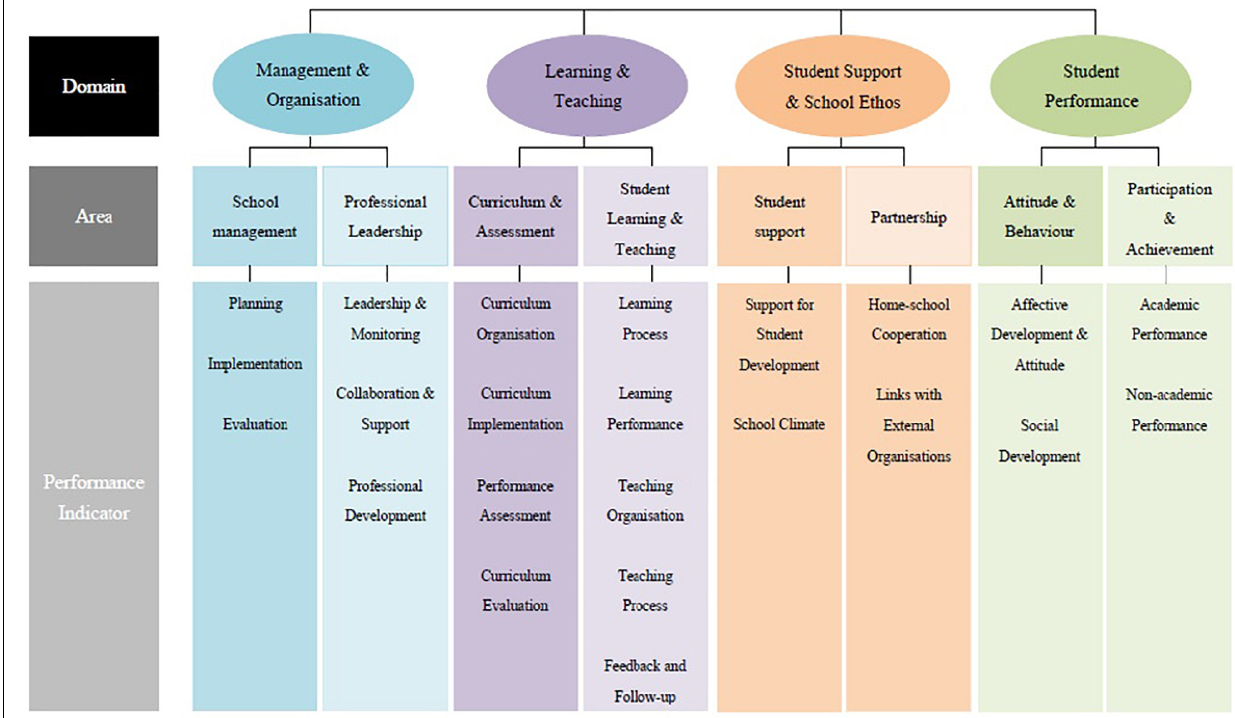
Frontiers in Psychology |